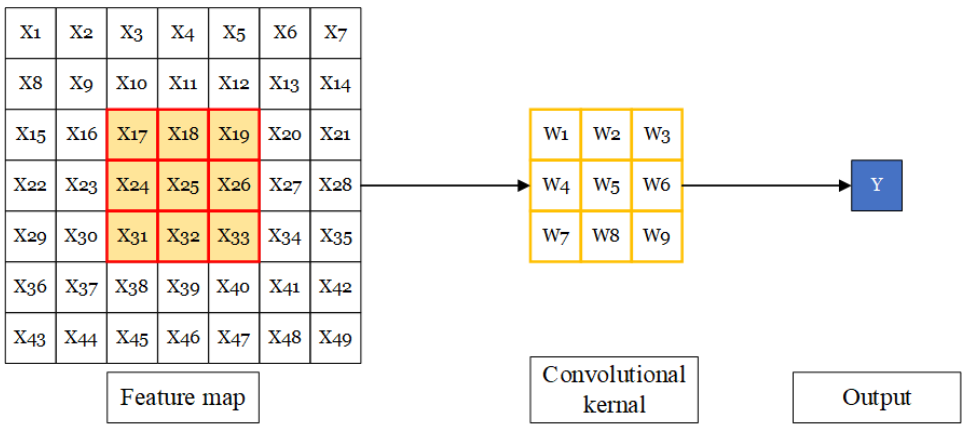
Figure 10. A standard convolutional